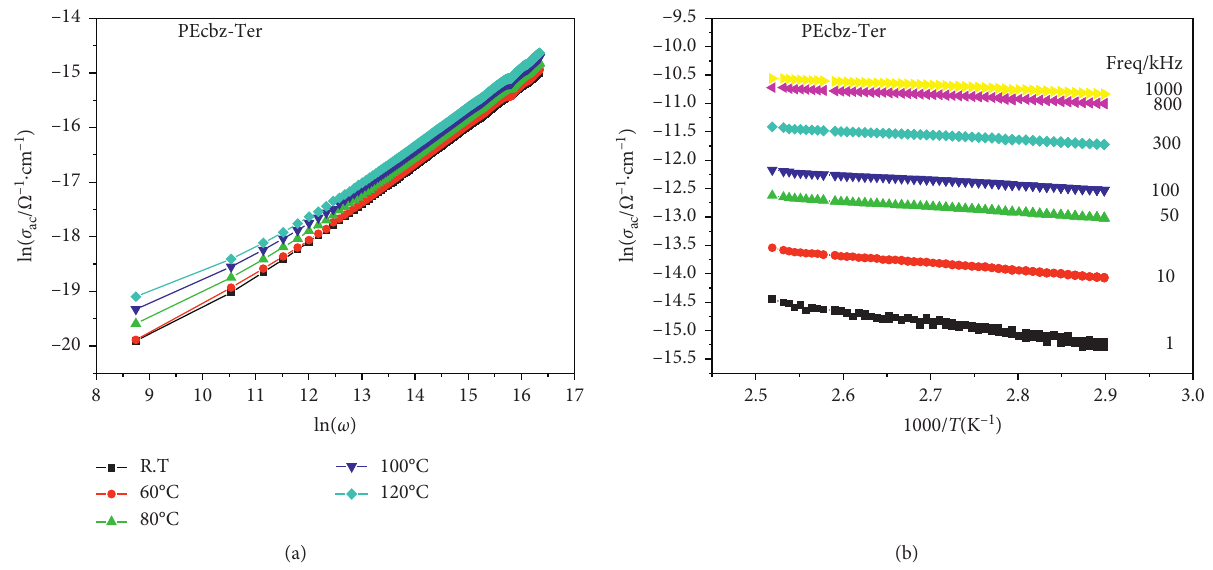
Figure 4: (a) AC conductivity vs. frequency of PEcbz-Ter at different temperatures. (b) AC conductivity vs. temperatures of PEcbz-Ter at different